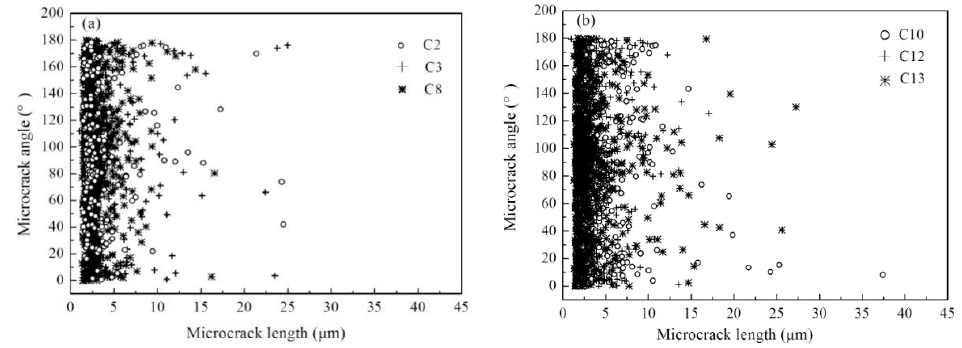
Figure 5. The length distribution of cracks under different angles in typical coatings: ( a ) APS coatings; ( b ) SAPS coatings.